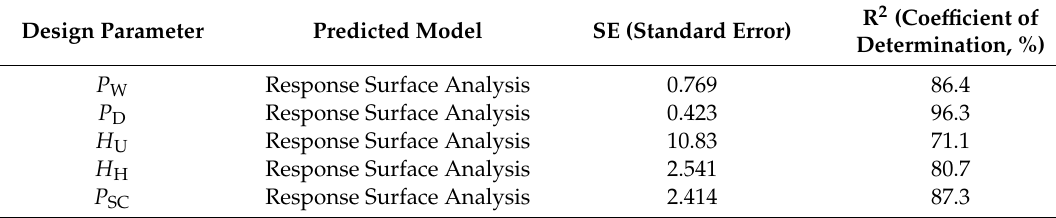
Table 11. Analysis variance tests for predicted model for welding